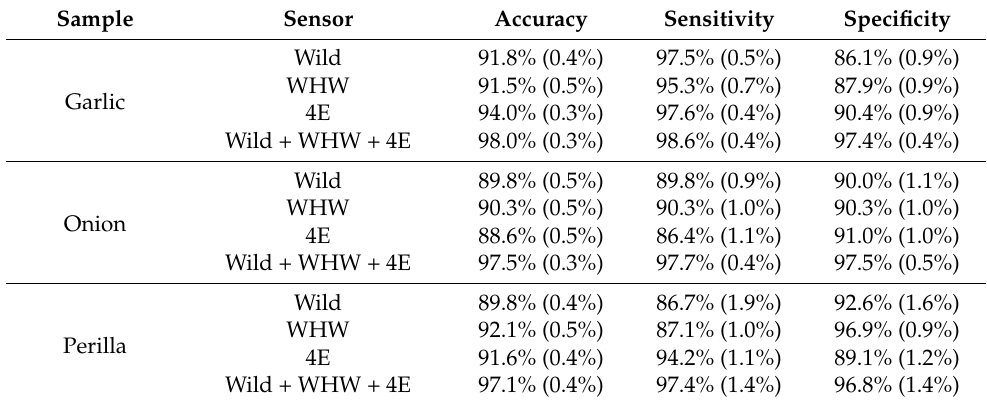
Table 1. Accuracy, sensitivity, and specificity of discrimination of domestic and imported garlic, onion, and perilla samples using SVM. The numbers in parentheses indicate the corresponding standard deviation in 1000-time cross